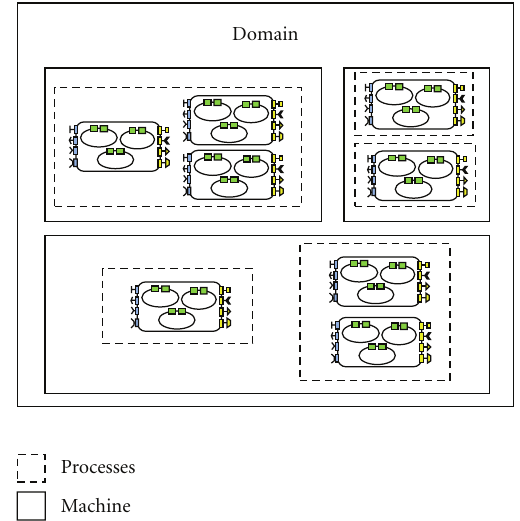
Figure 15: Example of the domain notion.